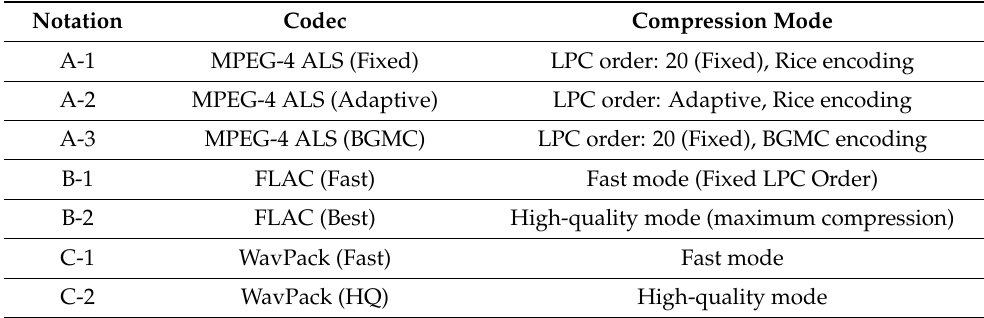
Table 2. List of candidate codecs and their compression mode.